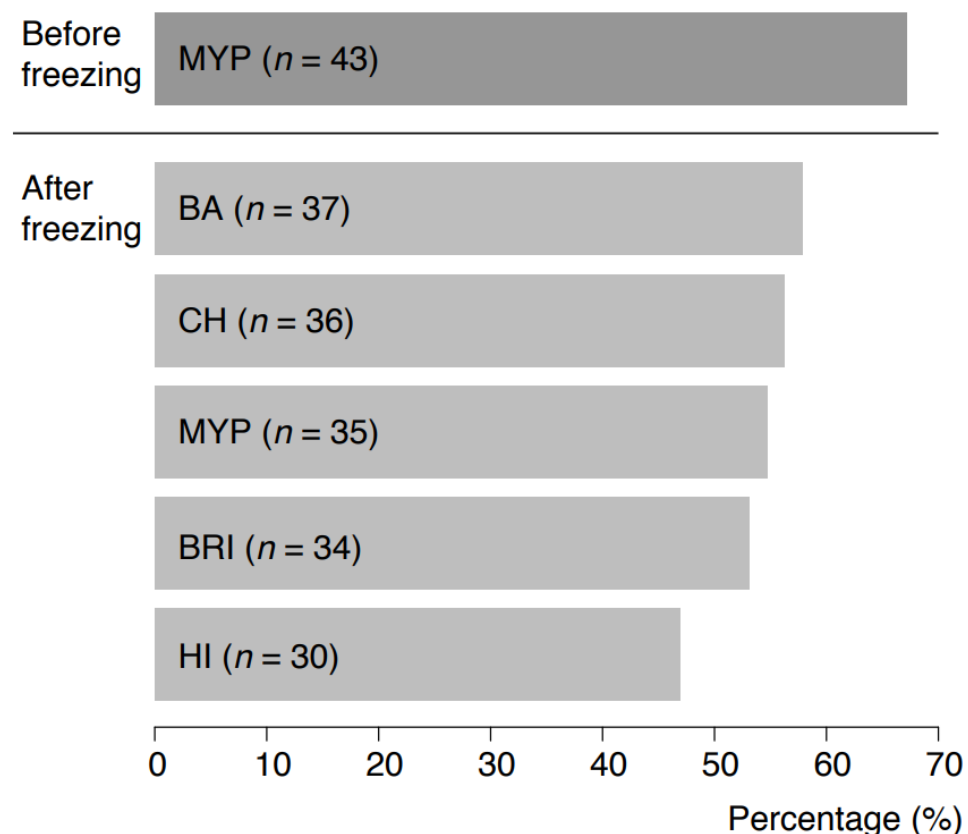
Figure 6. Detectability of Bacillus cereus sensu lato in 64 naturally contaminated food samples before freezing on MYP agar and after freezing on MYP agar and chromogenic media. Abbreviations: